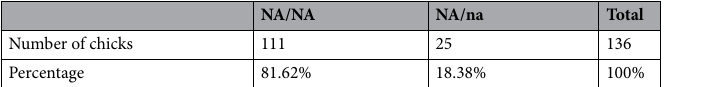
Table 3. Parental identification of chicks produced by Sharkasi mothers. NA/NA homozygous, NA/na heterozygous.